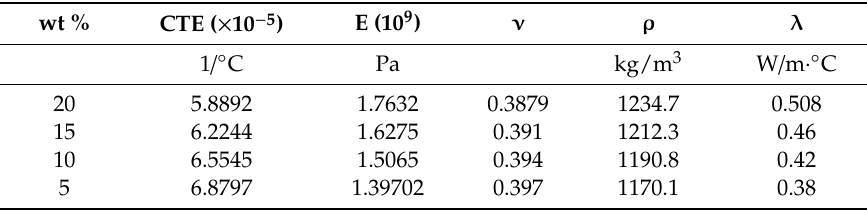
Table 3. Numerical physical-property composite parameters with di ff erent carbon